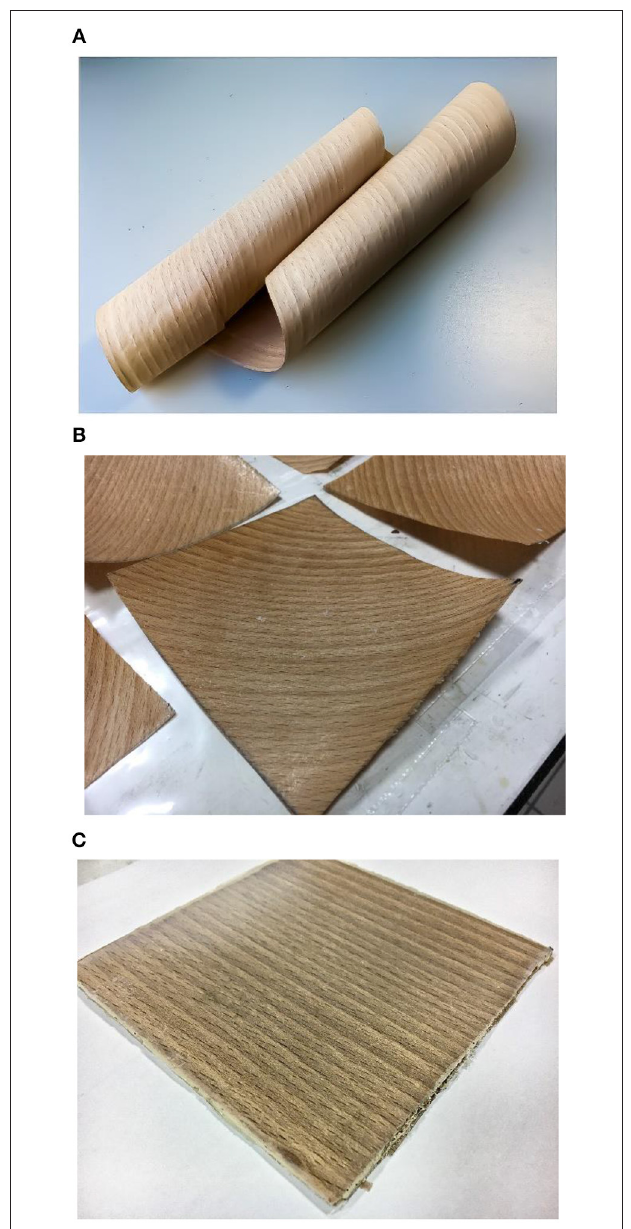
FIGURE 1 | Representative images of (A) neat wood lamina; (B) wood laminae after PEG impregnation; (C) wood/PEG/starch